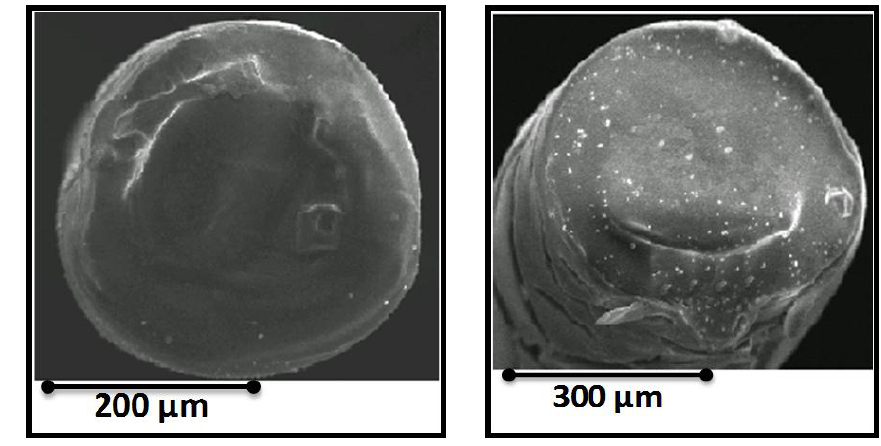
Figure 3. Scanning Electron Microscopy (SEM) of ( Left ) Pt-Nafion ® (1/2)PPD modified electrode, 200 μm dimensional bar ( Right ) Pt-Nafion ® (2/1)PPD modified sensor, 300 μm dimensional